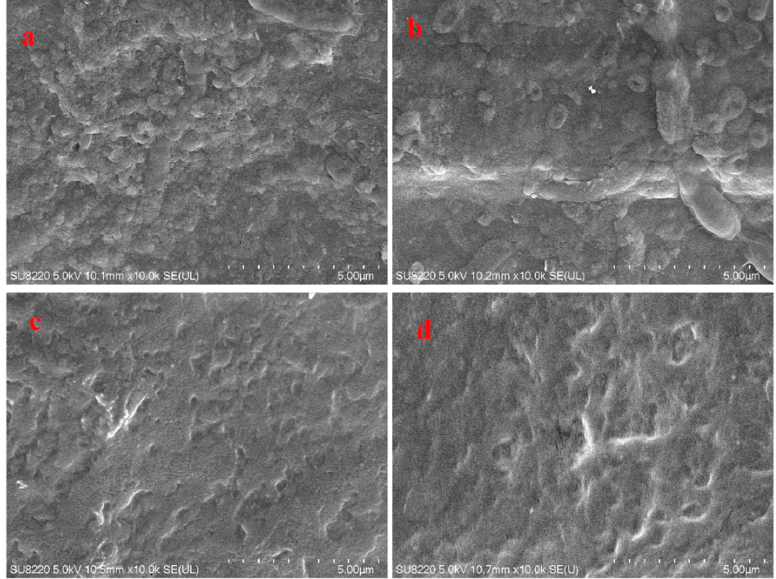
Figure 5. Scanning electron micrographs of LVPs extracted by different methods. ( a ) LVP-u; ( b ) LVP- m; ( c ) LVP-e; ( d )